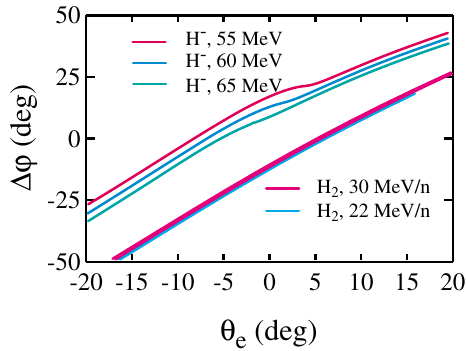
FIG. 4. (Color) Bending angle dependence on the exit point. A required bending angle, (cid:19) ’ , is defined as an angular difference between a beam direction and an extraction line direction. The extraction line connects the exit point and the starting point of (cid:13) are given for the the transport line. The dependencies (cid:19) ’ (cid:12) (cid:6) e classes of beams with K (cid:4) (cid:2) 1 and K (cid:4) 2 , to which belong the two beams with higher